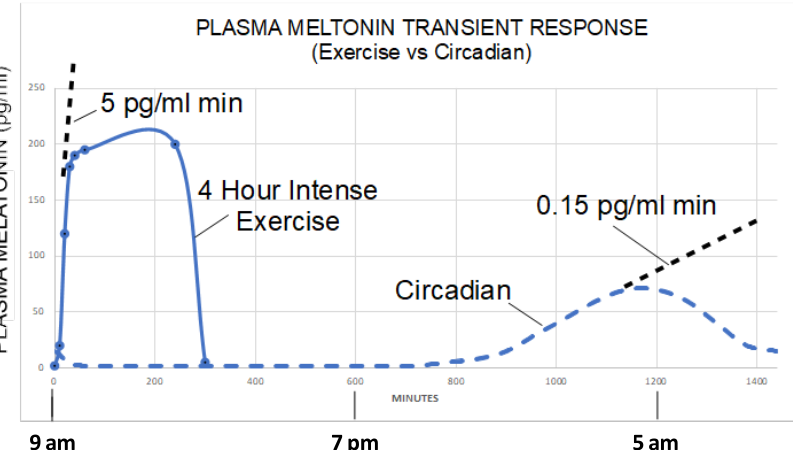
Figure 3. The plasma melatonin levels as a function of time during heavy exercise under sunlight and circadian time. During a 4-h intense exercise session, plasma melatonin levels rose to 200 pg/mL in 20 min followed by a plateau for the duration of the exercise (five test subjects with indwelling catheter measured plasma melatonin at 10, 20, 30, 40, 50, 60, 240, and 300 min, respectively). This figure was from [159] and permitted by the authors.